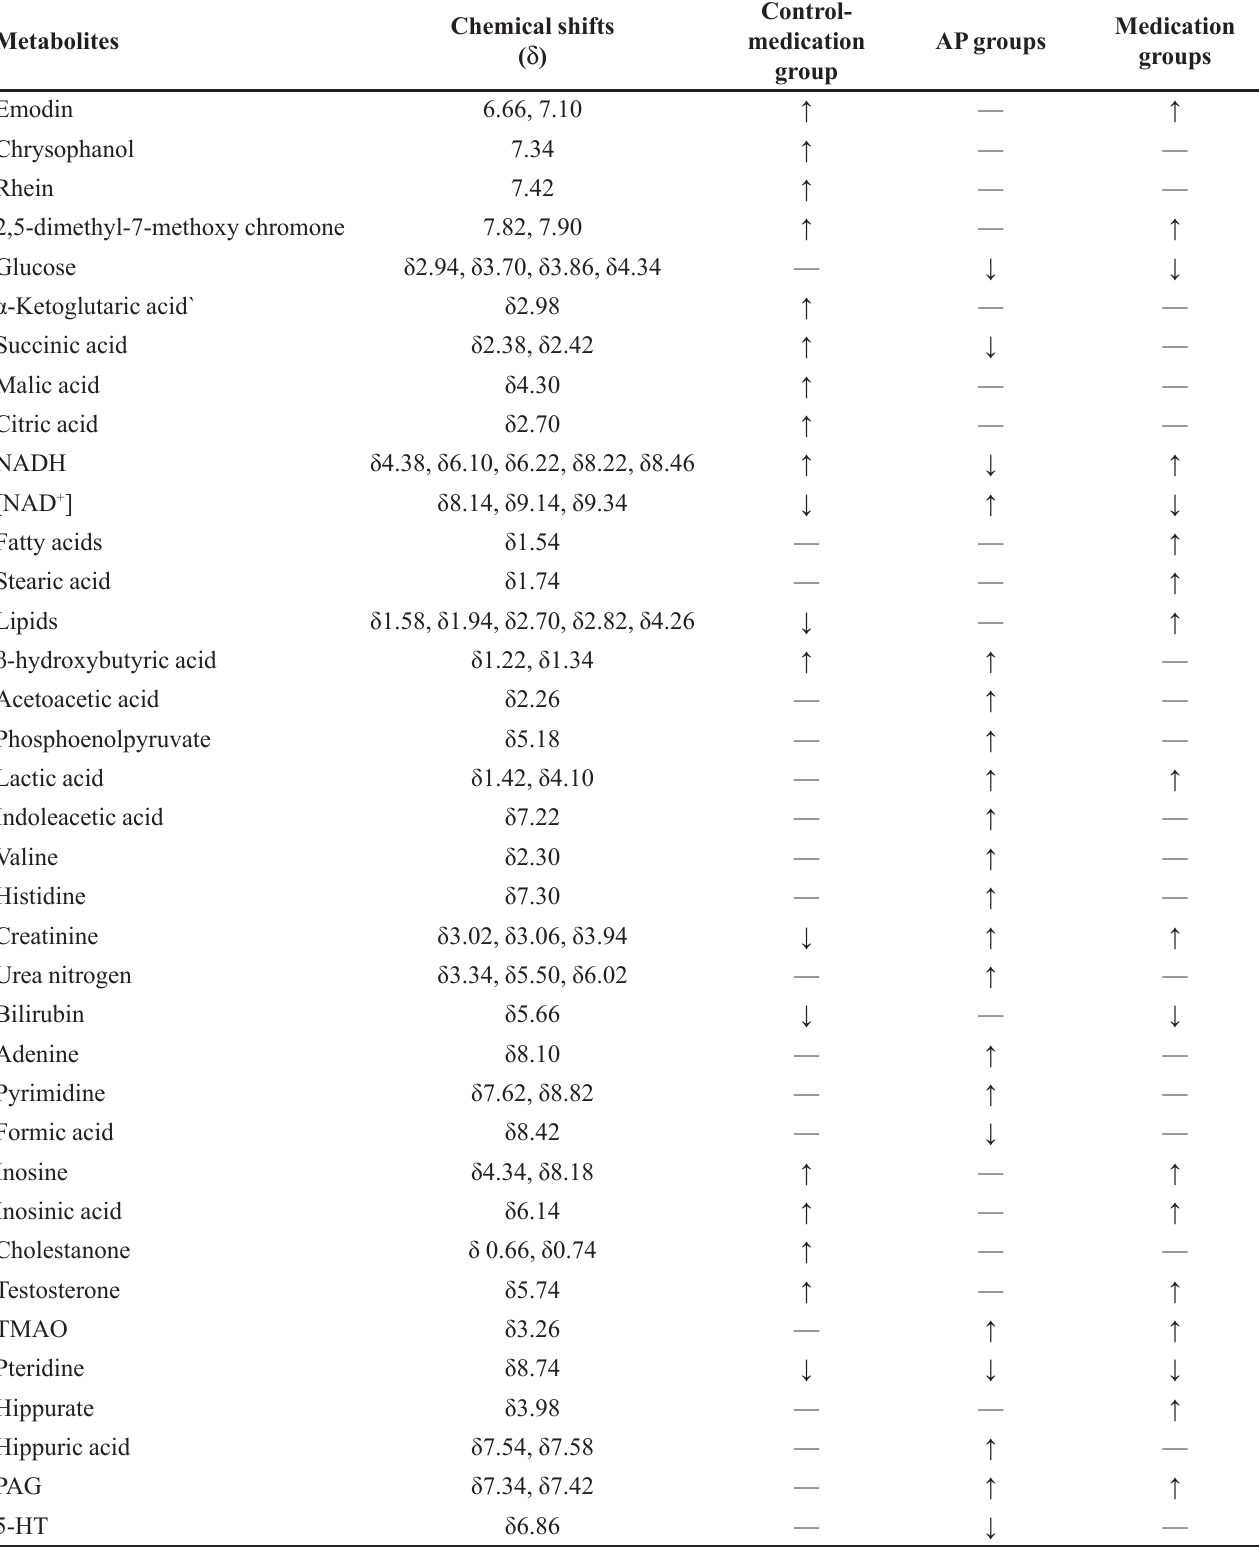
TABLE II - Summary of the variations in metabolites detected in the serum samples from the control-medication group, the acute pancreatitis (AP) groups (6-h, 12-h, and 24-h), and the medication groups (6-h, 12-h, and 24 h) compared with the control group